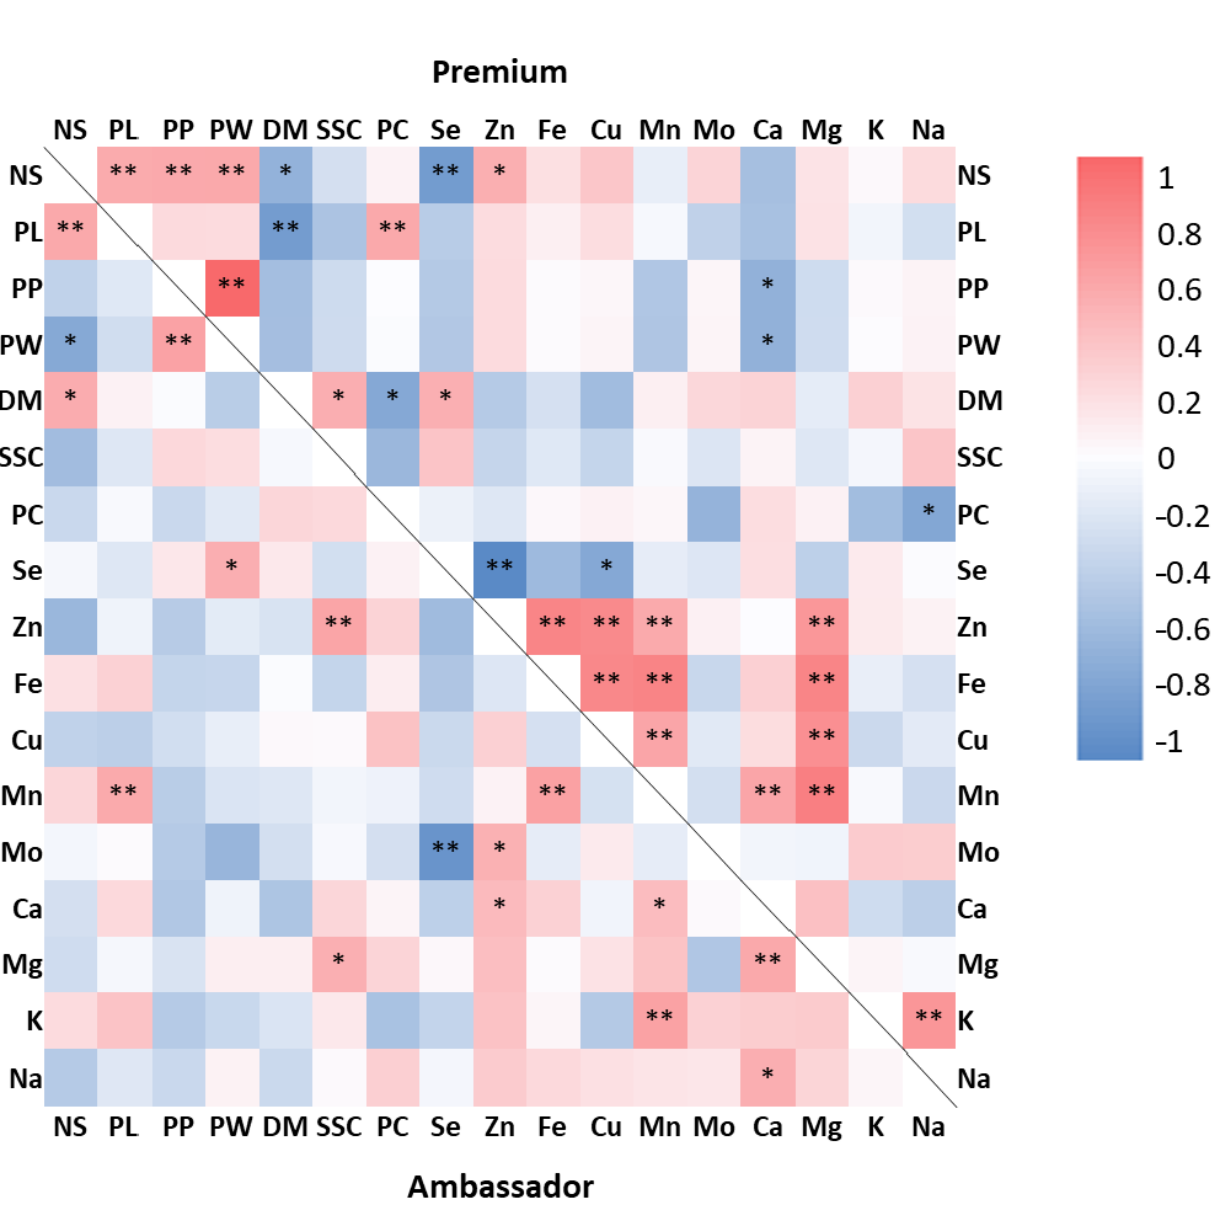
Figure 3. Correlation coefficients (Pearson) between growth parameters and mineral and macronutrient concentrations in seeds determined for the two pea varieties studied (Ambassador, Premium). NS: number of seeds/pod; PL: pod length; PP: pod perimeter; PW: pod width; DM: seed dry matter; SSC: soluble solid concentration; PC: protein concentration. Correlations below and above the black line indicate Ambassador and Premium, respectively. Significance level, * p < 0.05, ** p < 0.01.